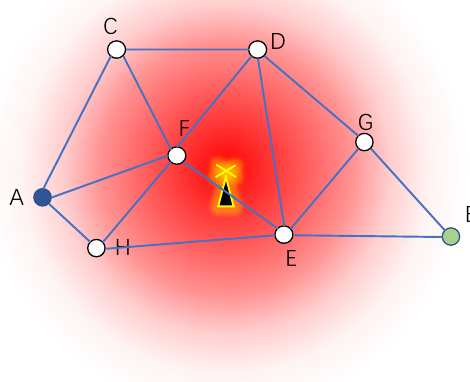
Figure 1. System model.